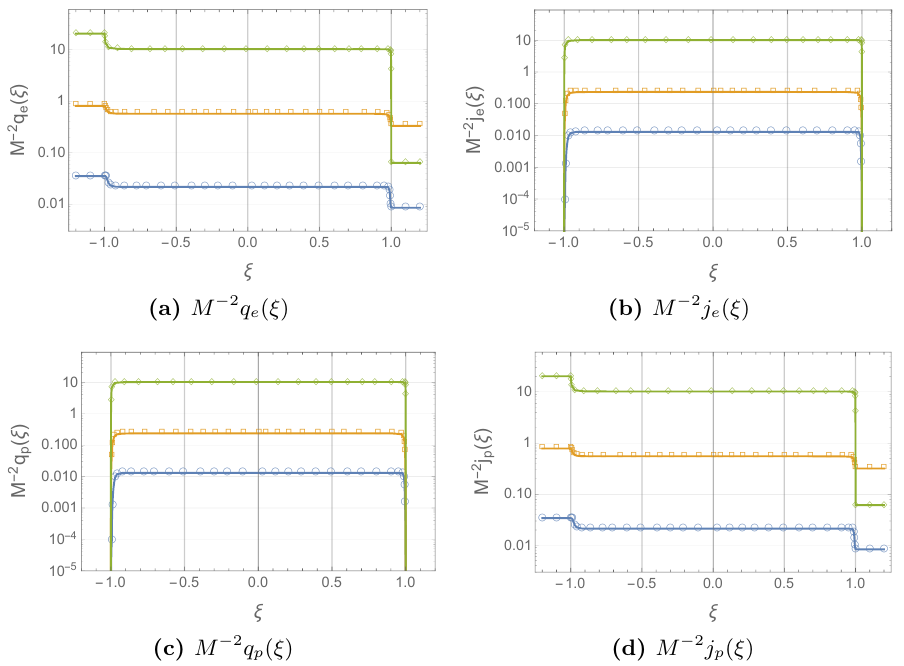
Figure 5. Ray-dependent (a) energy density q e , (b) energy current j e , (c) momentum density q p and (d) momentum current j p in the A 3 (tetra-critical to tricritical Ising) and D 3 (cid:13)ow after bipartite quenches at the Euler scale. The green curve with diamonds corresponds to left and right initial temperatures T l = 7 M and T r = 0 : 4 M , the orange curve with squares to T l = 1 : 4 M and T r = 0 : 9 M and the blue curve with circles to T l = 0 : 3 M and T r = 0 : 15 M . The discrete points in the plots indicated by the plotmarkers are obtained by the numerical solution of GHD equations, the continuous curves are (cid:12)rst order interpolations. Due to relativistic invariance, j e = q p .